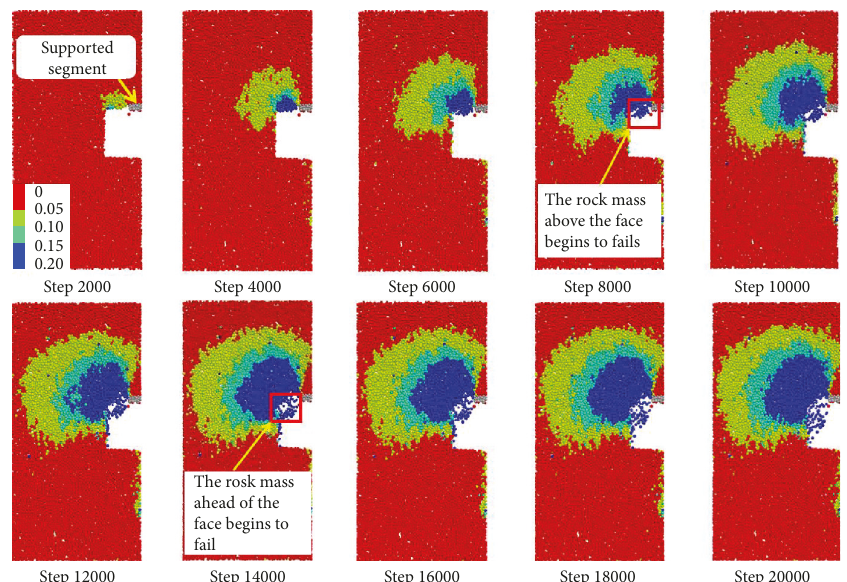
Figure 7: Displacement development process of the surrounding rock for the bench method with 2 m excavation footage. Unit: m.